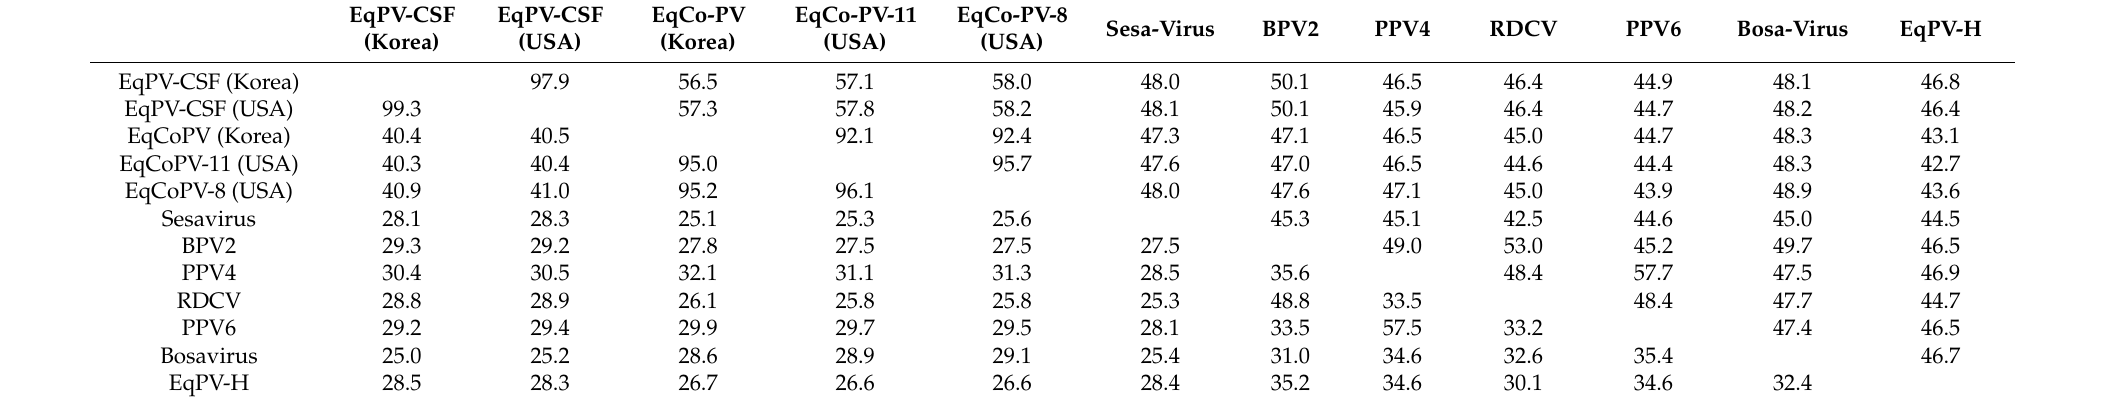
Table 4. Nucleotide (upper right) and amino acid (bottom left) similarities of the NS region in members of the genus Copiparvovirus